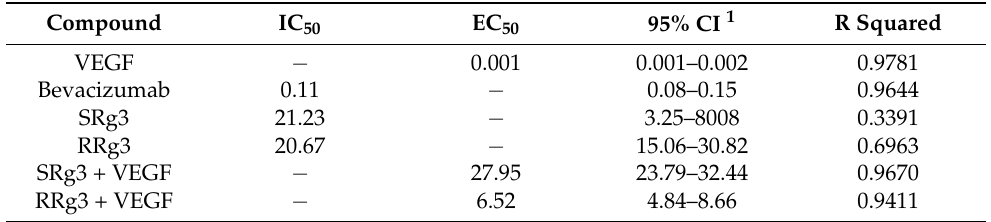
Table 3. Calculated IC 50 and EC 50 values for VEGF (ng/mL), bevacizumab ( µ g/mL), SRg3 ( µ M), and RRg3 ( µ M) alone or in combination with 35 ng/mL VEGF, in interaction with VEGFR2. The experiment was performed in duplicate using the VEGF bioassay system (Promega) and was analysed using Prism